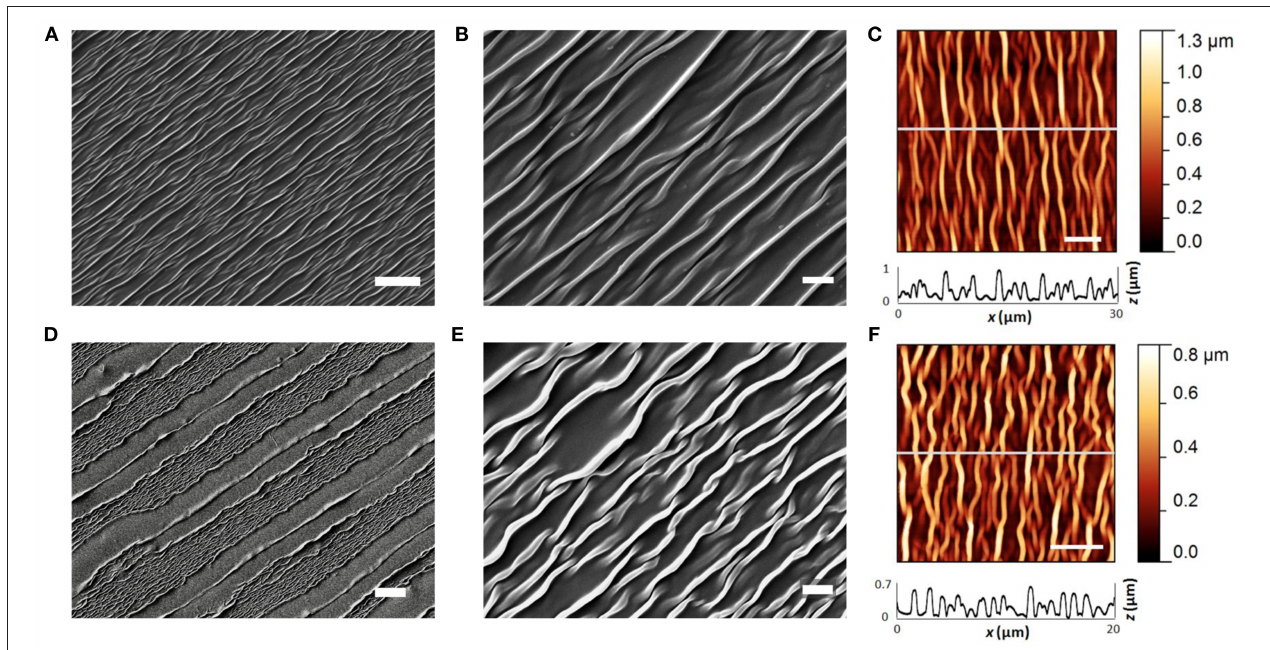
FIGURE 3 | PEDOT:PSS and SU-8 wrinkles. (A,B) SEM images of PEDOT:PSS wrinkled active site. Scale bar: 10 and 2 µ m. (C) AFM image of wrinkled PEDOT:PSS (scale bar: 5 µ m), and extracted x-z profile (gray line scan). (D,E) SEM images of SU-8 10% wrinkled micro-grooves. Scale bar: 20 and 2 µ m. (F) AFM image of wrinkled SU-8 10% (scale bar: 5 µ m), and extracted x-z profile (gray line scan).